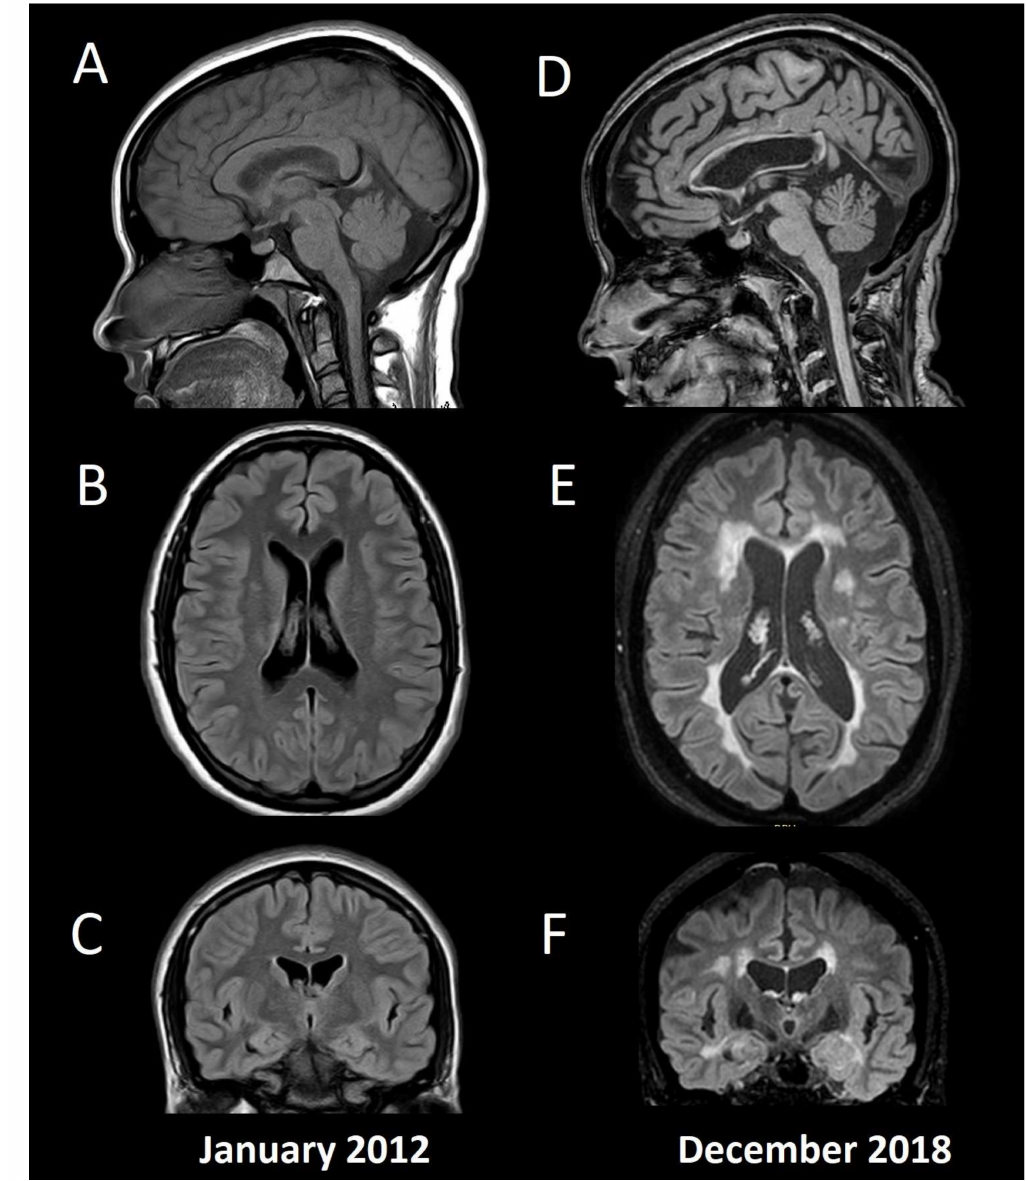
Figure 1. Conventional MRI in a patient with multiple sclerosis and cognitive impairment. Baseline MRI ( A : Sagittal T1, B : Axial FLAIR, C : Coronal FLAIR) from a 15-year-old female with fulminant MS (Marburg variant, EDSS 8.0). After initial aggressive treatment in 2012, including myeloablation with cyclophosphamide, the patient remained asymptomatic without disease modifying treatment, until